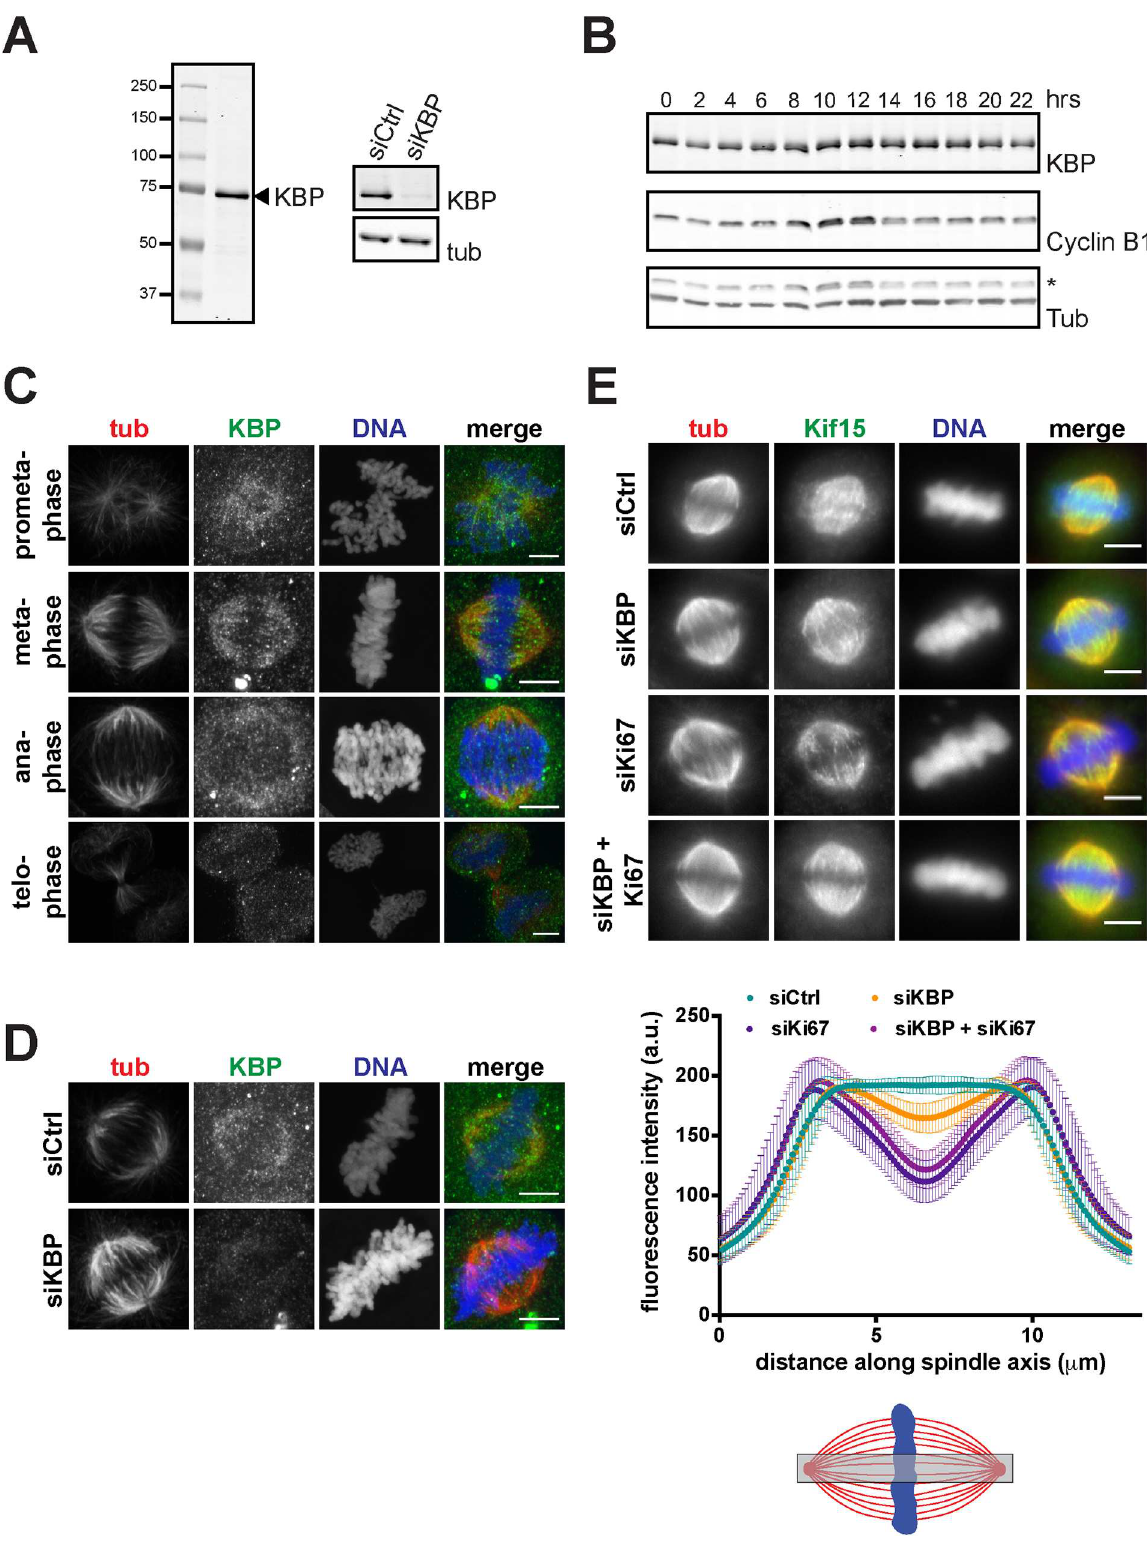
Fig 2. KBP promotes localization of Kif15 to the spindle midzone. (A) Left panel:Immunoblotof SDS-PAGE resolvedHeLa cell lysate with affinity-purified anti-KBP antibody. One single bandof about 72kDa is recognized. Right panel: Immunoblotof control or KBP silencedHeLa cell lysates. Membranes were probedwith anti-KBP and anti-tubulin,as a loadingcontrol, antibodies. (B) Cell